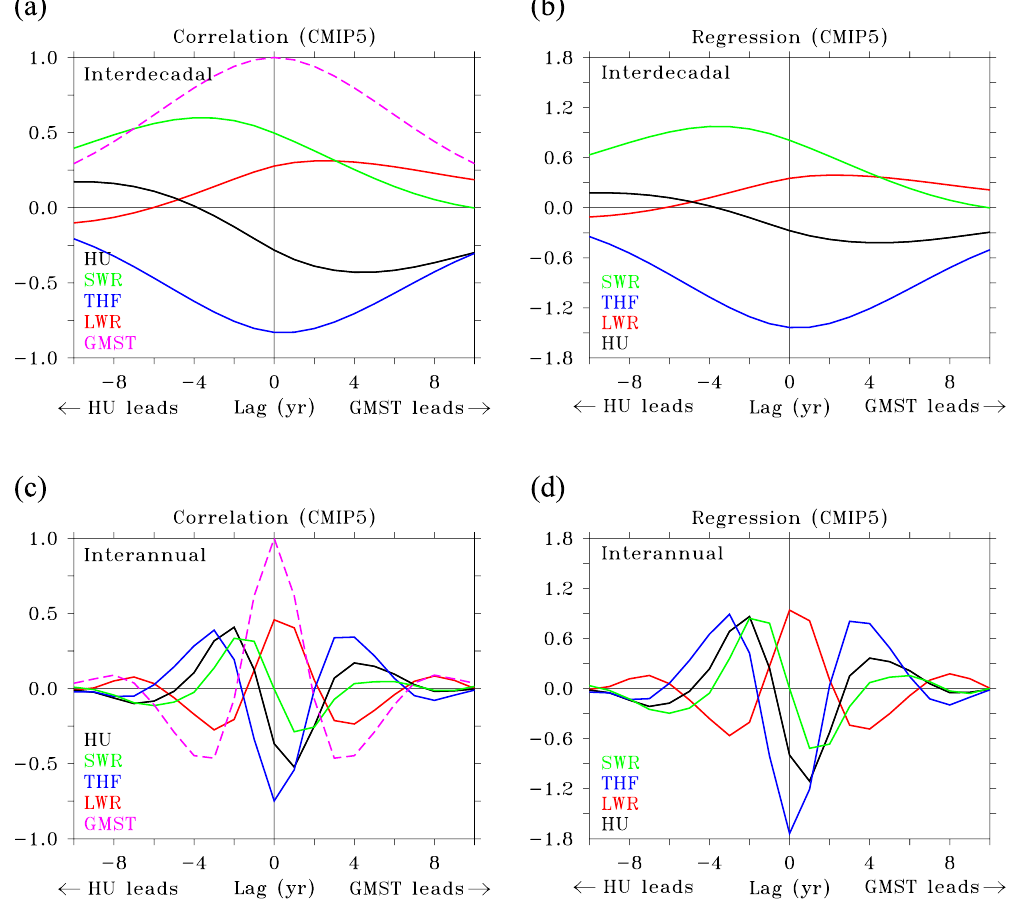
Figure 1. Relationship between GMST and HU in natural variability. ( a – d ) Lagged correlation ( a ) and lagged regression ( b ) of net heat uptake HU, net shortwave radiation (SWR), net longwave radiation (LWR) and turbulent (sensible plus latent) flux (THF; all positive downward) against GMST, based on decadal variations. Positive lags indicate that GMST leads; negative lags indicate that HU leads. Correlation is dimensionless. Regression values are in W m − 2 K − 1 . Lagged correlation ( c ) and lagged regression ( d ) for inter-annual